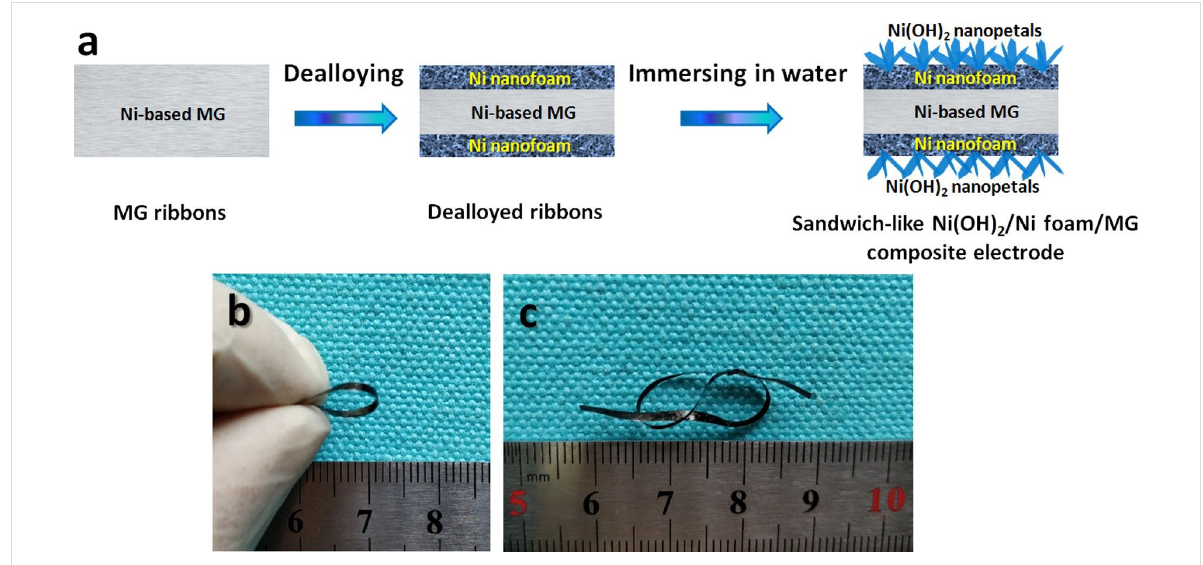
Figure 1: (a) Schematics of the fabrication process of the sandwich-like Ni(OH) 2 /Ni-NF/MG composite electrodes; (b, c) photographs of the as-fabri- cated electrodes with excellent